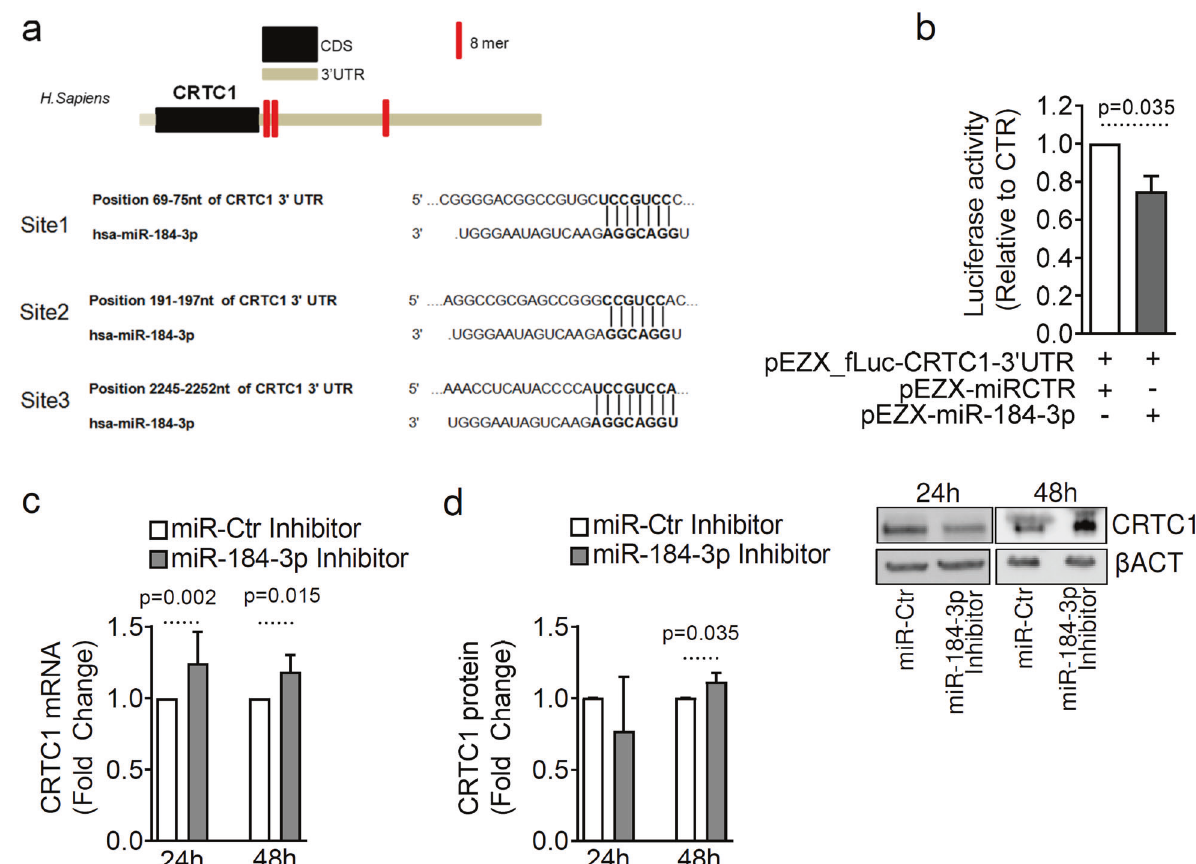
Fig. 3 miR-184-3p directly modulates the expression of CRTC1. a Top panel: graphical representation of CRTC1 mRNA sequence (ENST00000338797.6) showing 3 ’ UTR and predicted hsa-miR-184-3p binding sites (in red); bottom panel: nucleotide position of hsa-miR-184- 3p binding sites and sequence context within the 3 ’ UTR region of CRTC1 mRNA. b Luciferase assay in HeLa cells transfected with a plasmid overexpressing hsa-miR-184-3p compared to cells transfected with a scrambled vector; values are given as mean ± SD of relative luciferase activity compared to control, after normalisation of fi re fl y luciferase unit to renilla luciferase activity; statistics using Mann – Whitney U test ( n = 4 independent experiments). c RT-Real-time PCR analysis of CRTC1 expression in EndoC- β H1 cells transfected with a synthetic inhibitor of hsa-miR-184-3p; data are expressed as fold change compared to scrambled control; Mann – Whitney U test statistics ( n = 6 independent experiments). d Western blot analysis of CRTC1 (78 kDa) in EndoC- β H1 cells transfected with a synthetic inhibitor of hsa-miR-184-3p. Data are presented as mean ± SD of fold-change values of normalised CRTC1/ β -Act ratio of miR-184-p inhibitor vs. miR-Ctr inhibitor-transfected samples; statistics using paired Student ’ s t -test ( n = 6 independent